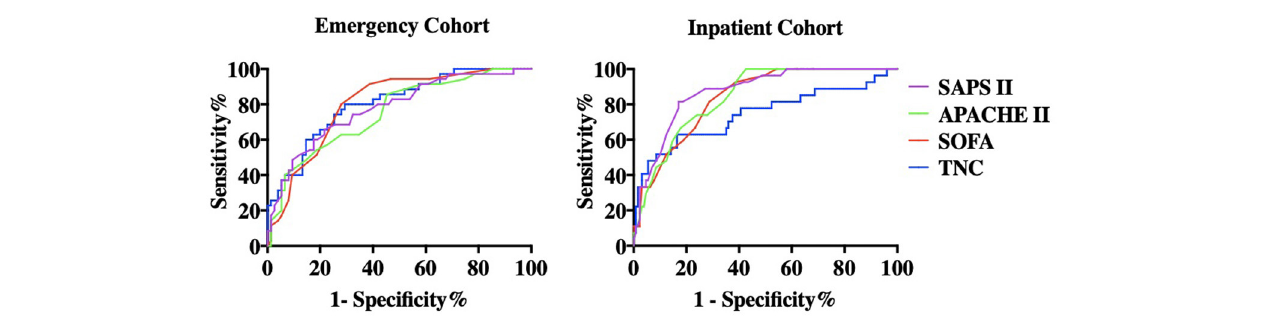
FIGURE 1 | Receiver Operating Characteristics (ROC) curve in both cohorts. The areas under ROC (AUC) of serum TNC, SOFA, APACHE II, and SAPS II for predicting all-cause mortality were 0.803, 0.808, 0.762, and 0.779 ( p < 0.001 for all) in the emergency (derivation) cohort and 0.745, 0.844, 0.846, and 0.872 ( p < 0.001) in the inpatient (validation) cohort. In the emergency cohort, there was no significant difference between serum TNC and the three critical illness scores. In the inpatient cohort, the AUC of serum TNC was significantly lower than SAPS II ( p = 0.032) while there was no significant difference between serum TNC and SOFA or APACHE